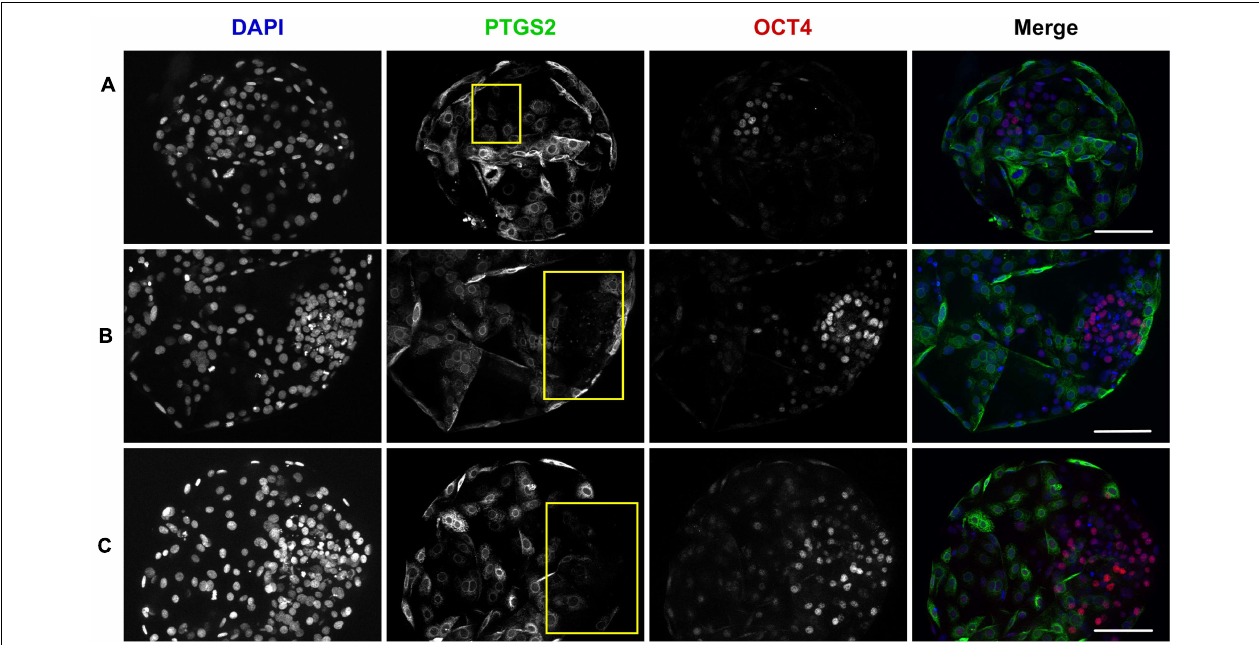
FIGURE 2 | Photomicrographs show representative image stacks of surviving day 3 post-thaw bovine embryos with low (A) , medium (B) , and high (C) proportions of OCT4 positive cells in the ICM. Embryos are stained for PTGS2 (green) and OCT4 (red) expression by immunofluorescence. The chromatin is counterstained with DAPI (blue). The ICM is outlined in yellow. (Scale bars, 100 µ m).